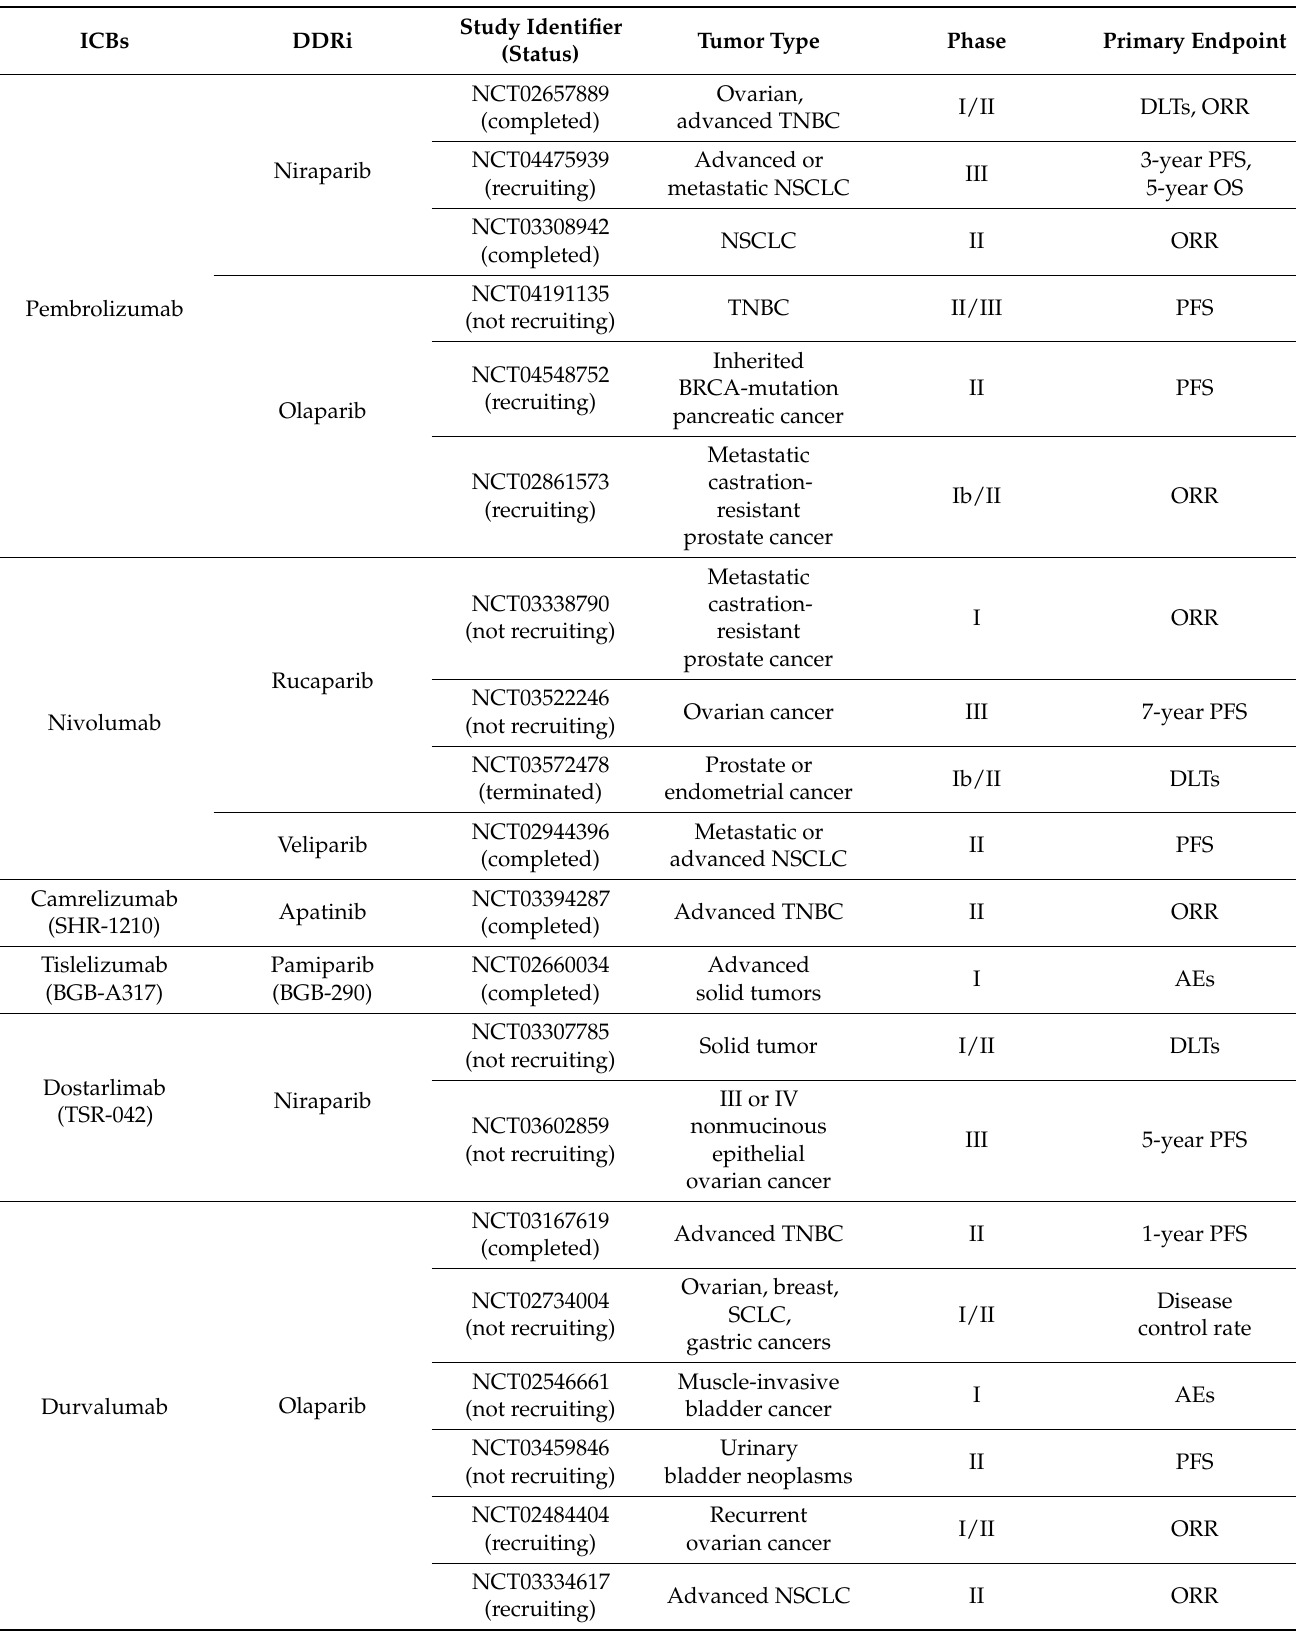
Table 2. Clinical Trials Using immune checkpoint blockade (ICB) + DNA Damage Response inhibition (DDRi). (https://clinicaltrials.gov (accessed on 1 November